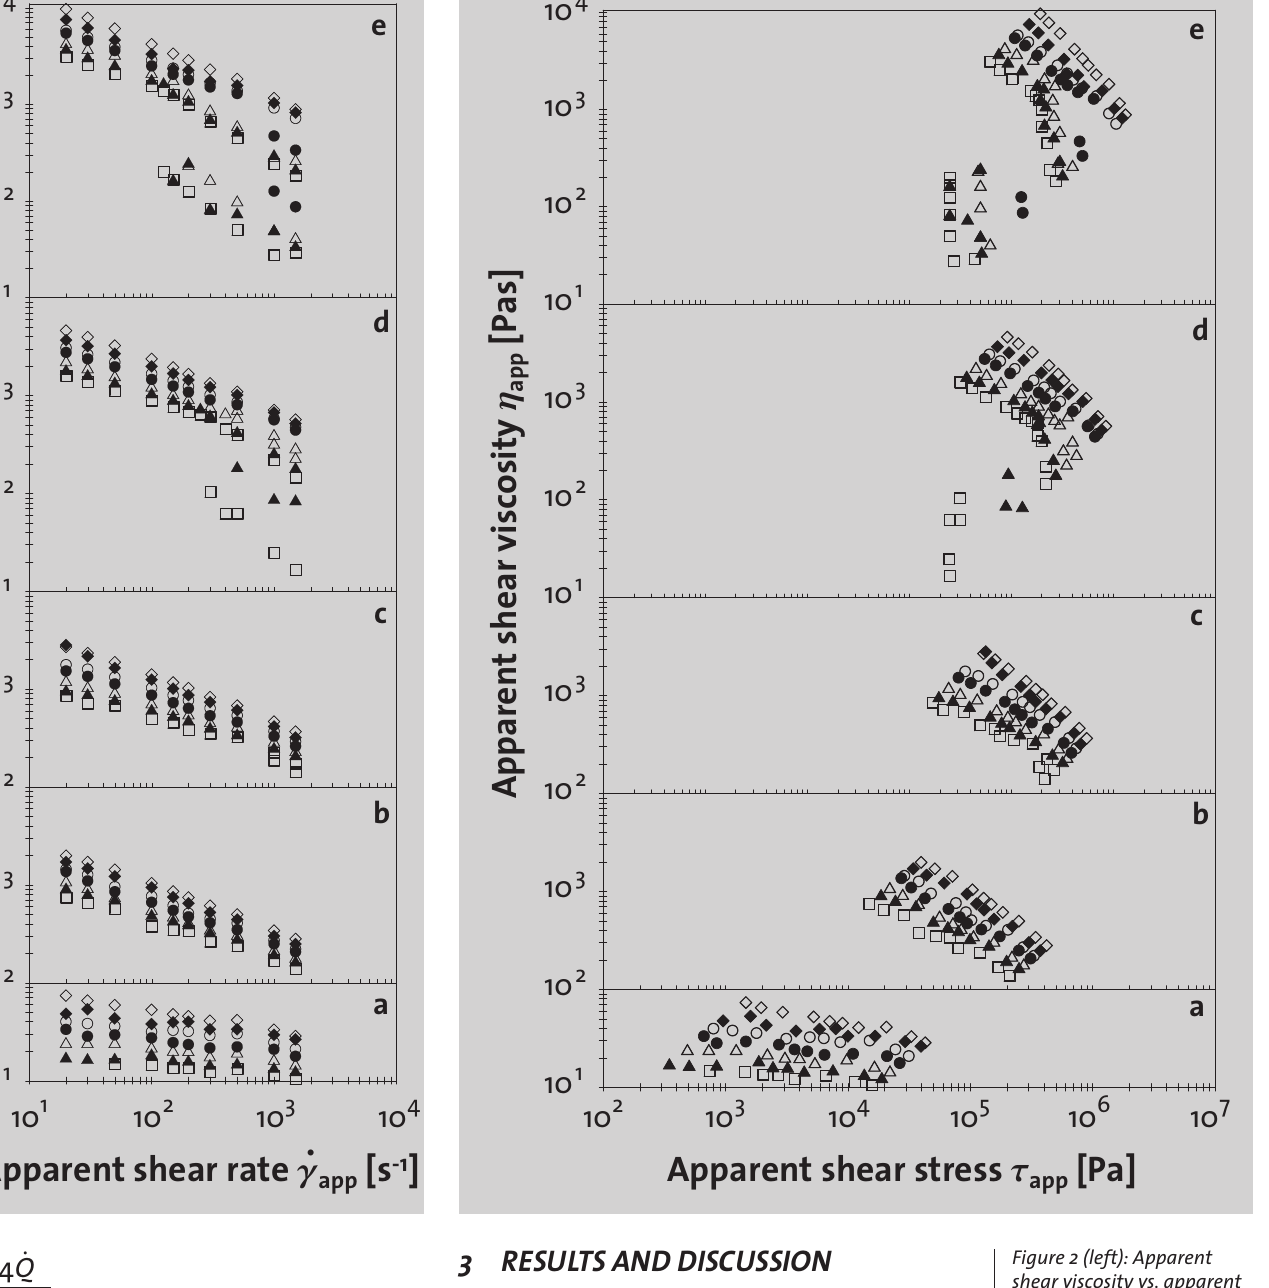
Figure 2 (left): Apparent shear viscosity vs. apparent shear rate at temperatures 140 ( Ì ), 150 ( Ï ), 160 ( Á ), 170 ( Ê ), 180 ( Û ), 190 ( Ú ) and 200˚C ( · ) for compounds containing 0 (a), 40 (b), 45 (c), 50 (d), 55 (e) vol. % carbide powder (Goettfert, L CAP /D CAP ratio 20/1). Figure 3 (right): Apparent shear viscosity vs. apparent shear stress at temperatures 140 ( Ì ), 150 ( Ï ), 160 ( Á ), 170 ( Ê ), 180 ( Û ), 190 ( Ú ) and 200˚C ( · ) for compounds containing 0 (a), 40 (b), 45 (c), 50 (d), 55 (e) vol. % carbide powder (Goettfert, L CAP /D CAP ratio